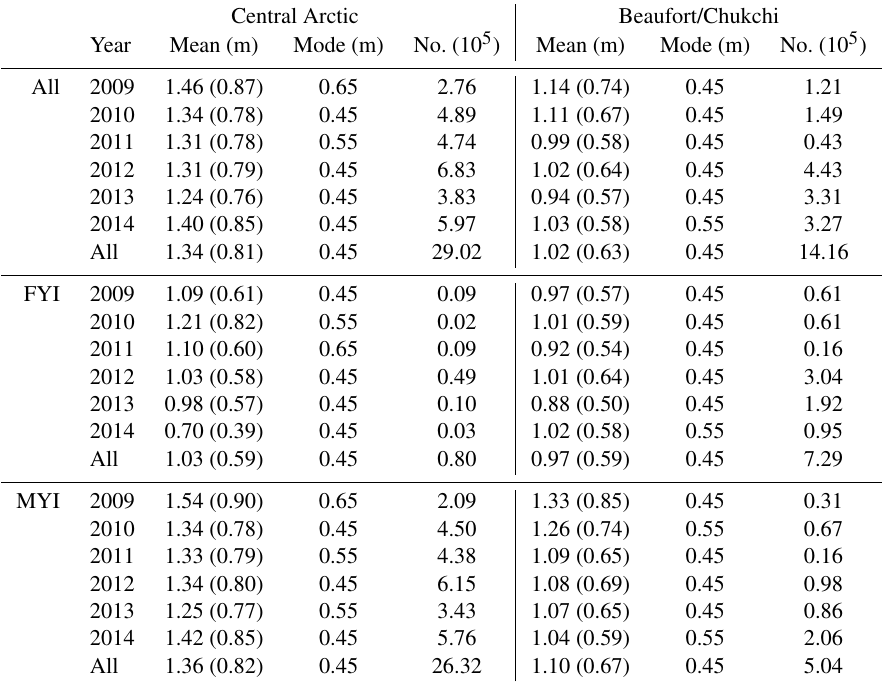
Table 2. Surface feature height statistics (mean and mode) taken from the probability distributions shown in Fig. 6. The value in the brackets (next to the means) equals 1 standard deviation of the relevant distribution. The third column (under each region) shows the number of surface features